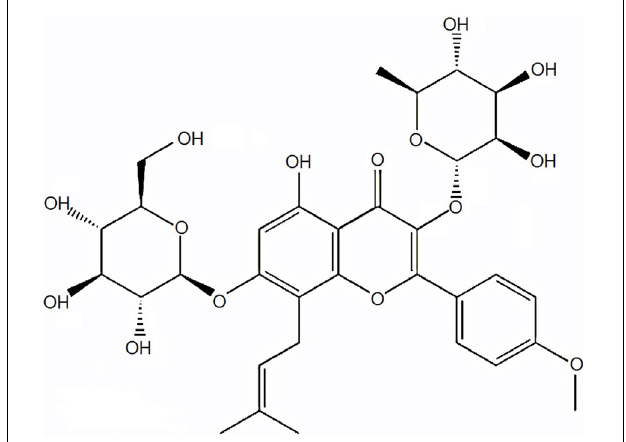
FIGURE 1 | Chemical structure of icariin